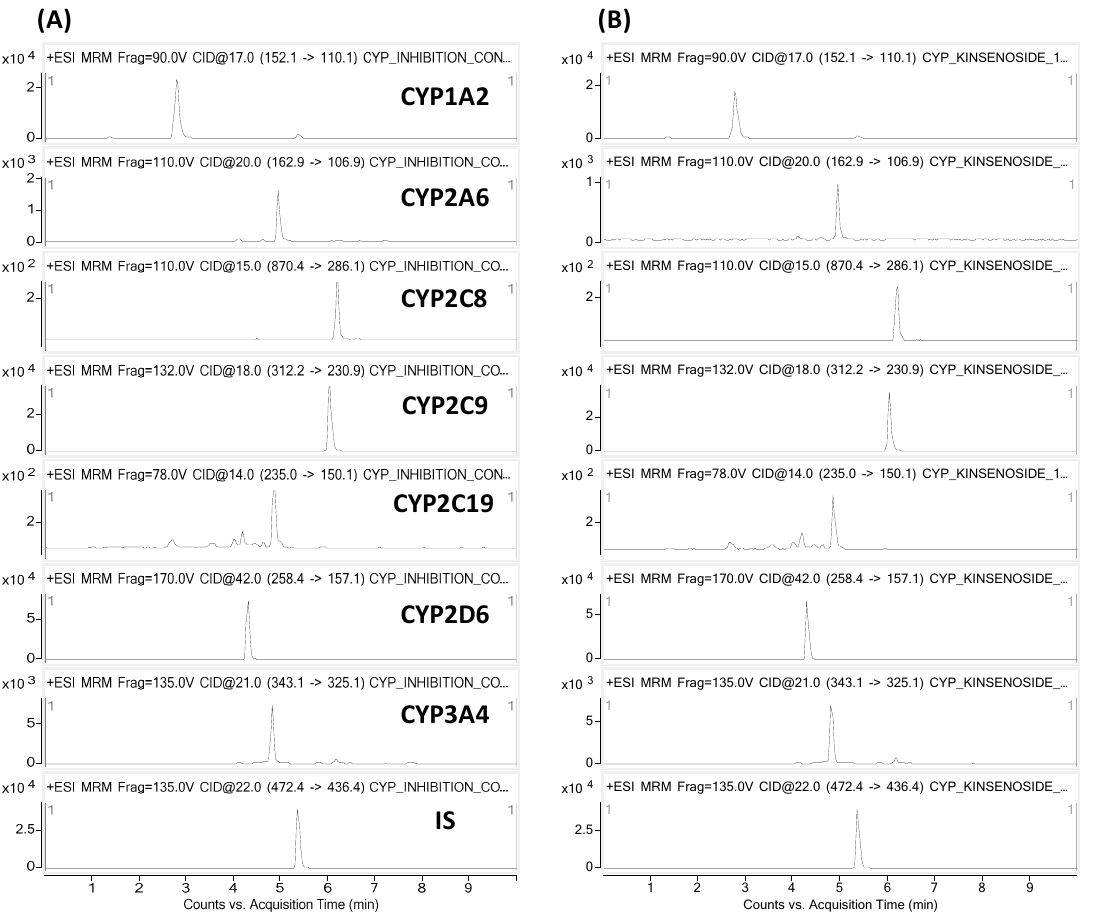
Figure 1. Representative MRM chromatograms of human liver microsome samples of ( A ) control and ( B ) kinsenoside (100 µM)-treated. Human liver microsomal fraction was incubated with the substrate mixture, NADPH-generating system, and kinsenoside for 30 min and the formation of the CYP-specific metabolites was determined by LC-MS/MS. Table 1. Effects of kinsenoside on CYP-specific metabolite formation in human liver microsomes.